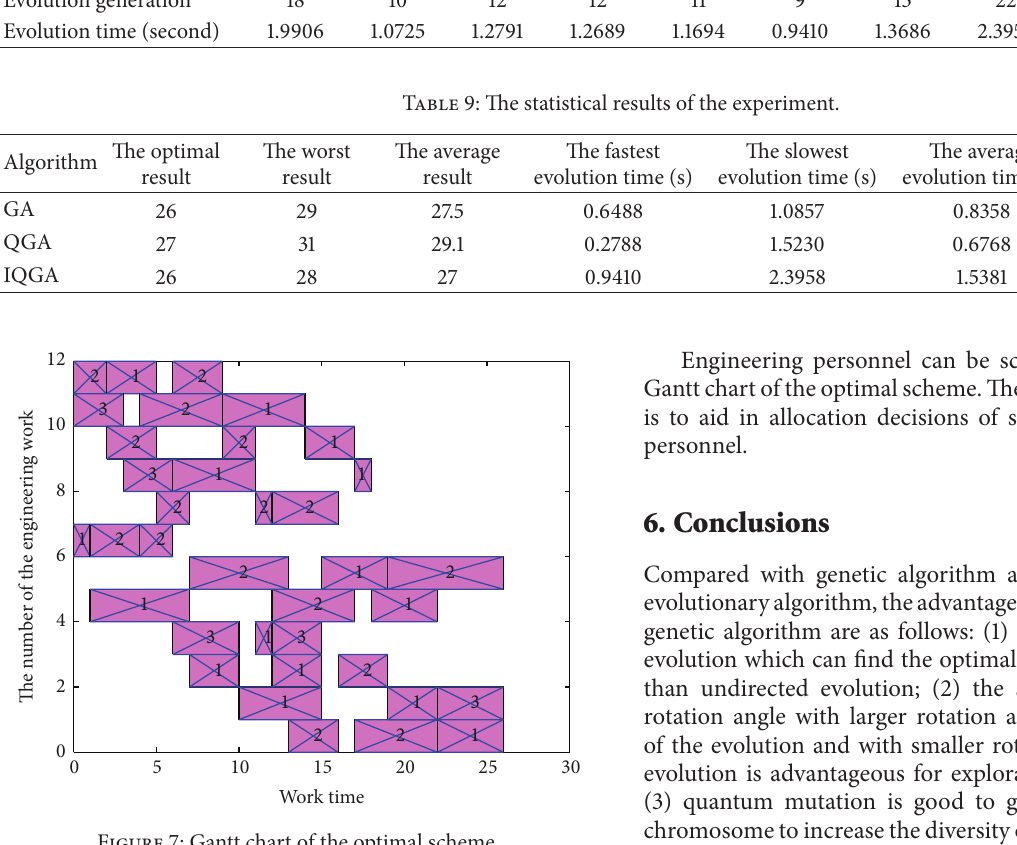
Figure 7: Gantt chart of the optimal scheme. In Figure 7, x -axis represents time; y -axis represents the number of the engineering work. The length of the rectangles represents the work time of the engineering work; the number in the rectangle represents the number of the work group of the corresponding